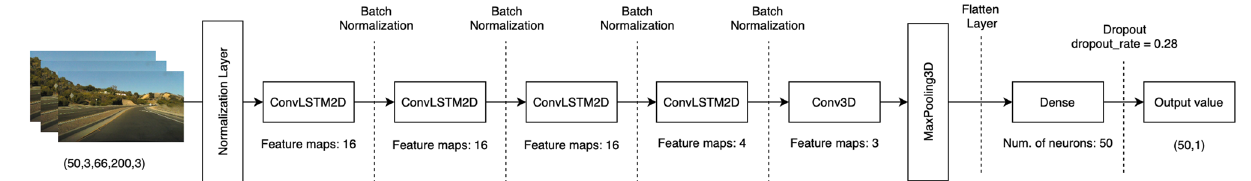
Figure 5. Structure of BO_ST-LSTM architecture. Images used at the beginning of the structure come from the SullyChen Dataset 43 .